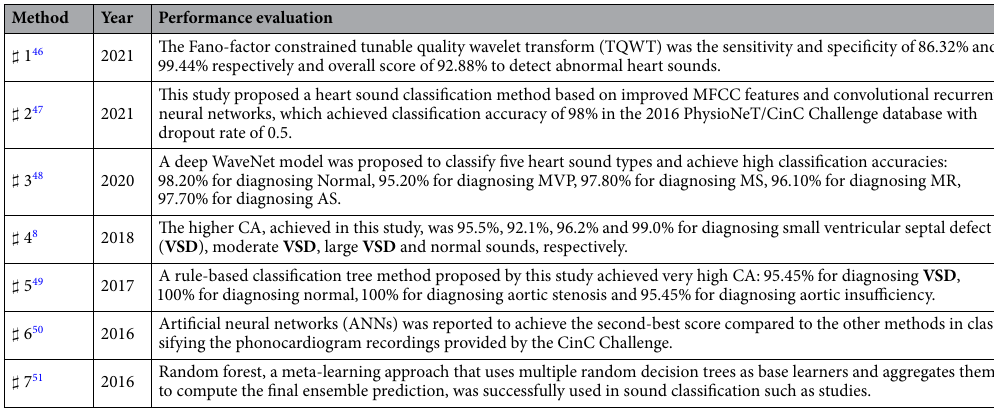
Table 6. Efficient methods successfully used in diagnosing normal sounds from other common heart